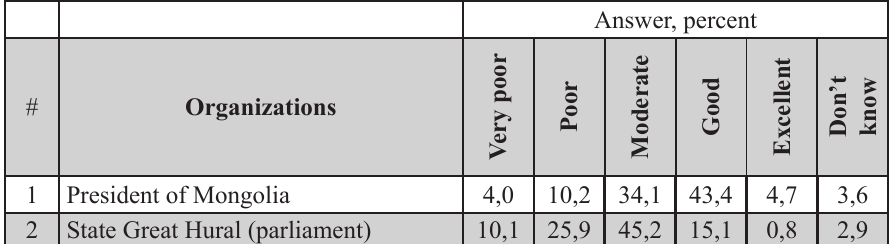
Table 6. Public Perception of Activities of State Organizations